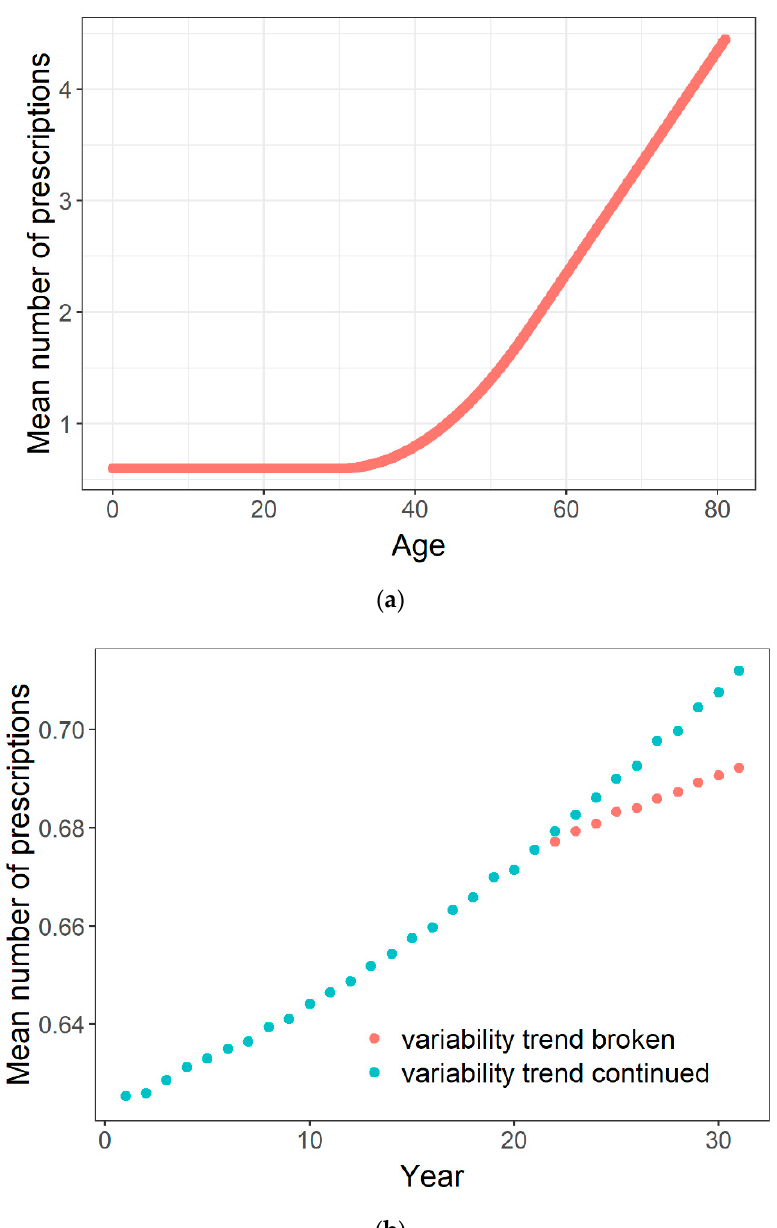
Figure 1. ( a ) The number of prescriptions in the six months up to conception is roughly stable up to age 30, then increases supra-linearly with age up to about age 55, after which it increases linearly with age at about 1 prescription per 10 years of age. ( b ) A simulation where both the mean and variability (standard deviation) of the age distribution increase linearly over calendar time. The pastel red dots demonstrate what would happen if the variability trend stopped at the 21 st year. Assumed is a normal distribution with parameters taken approximately from reference 20, with sufficient detail to prove the principle. For the turquoise dots, the mean is assumed to increase from 30 to 33 years by 0.1 year per year, while the standard deviation increases from 5 to 8 years, also by 0.1 year per year. For the pastel red dots, the mean trend is identical, but the standard deviation is kept constant at 7 from year 21